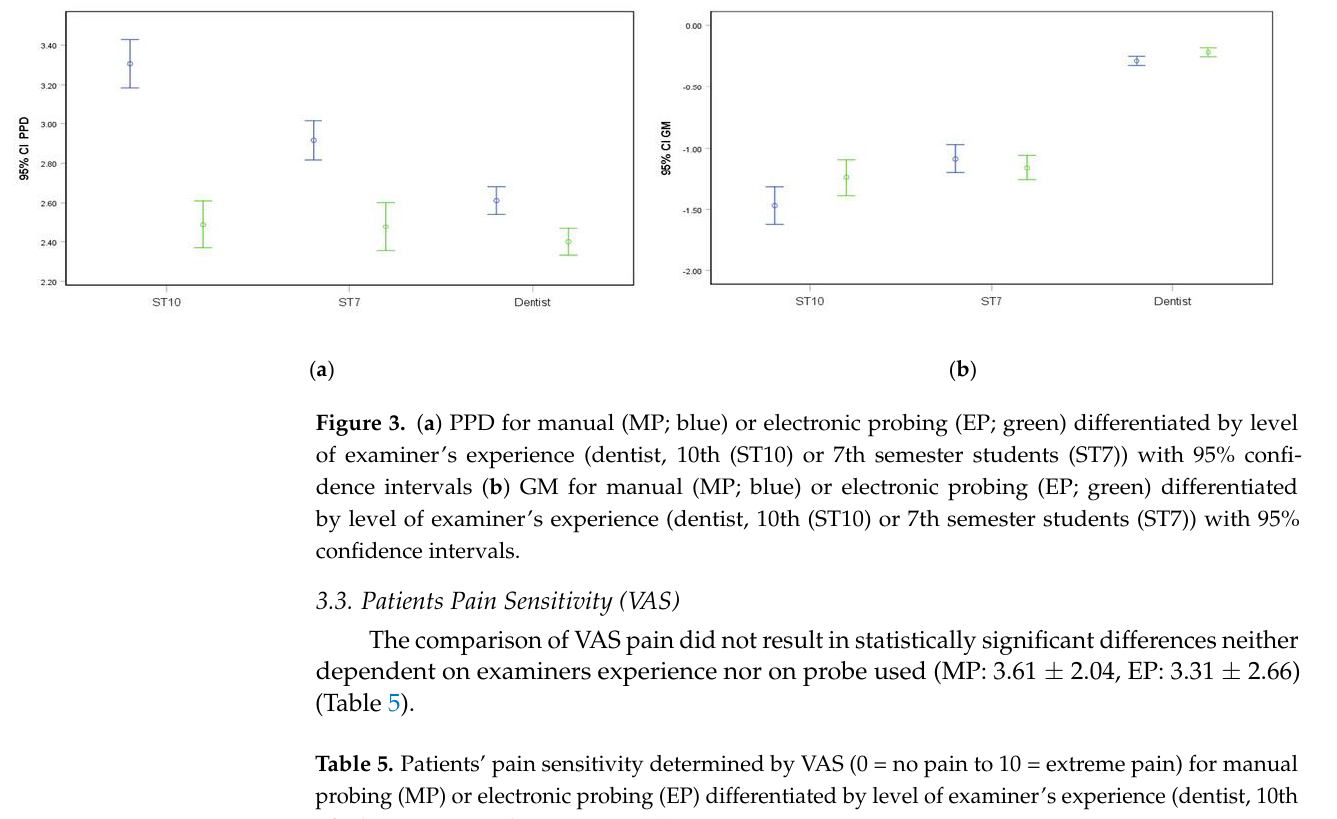
Table 4. Time needed for manual probing (MP) and electronic probing (EP) (in min) differentiated by level of examiner ’ s experience (dentist, 10th of 7th semester students, ST10, ST7). Table 5. Patients’ pain sensitivity determined by VAS (0 = no pain to 10 = extreme pain) for manual probing (MP) or electronic probing (EP) differentiated by level of examiner’s experience (dentist, 10th of 7th semester students, ST10,